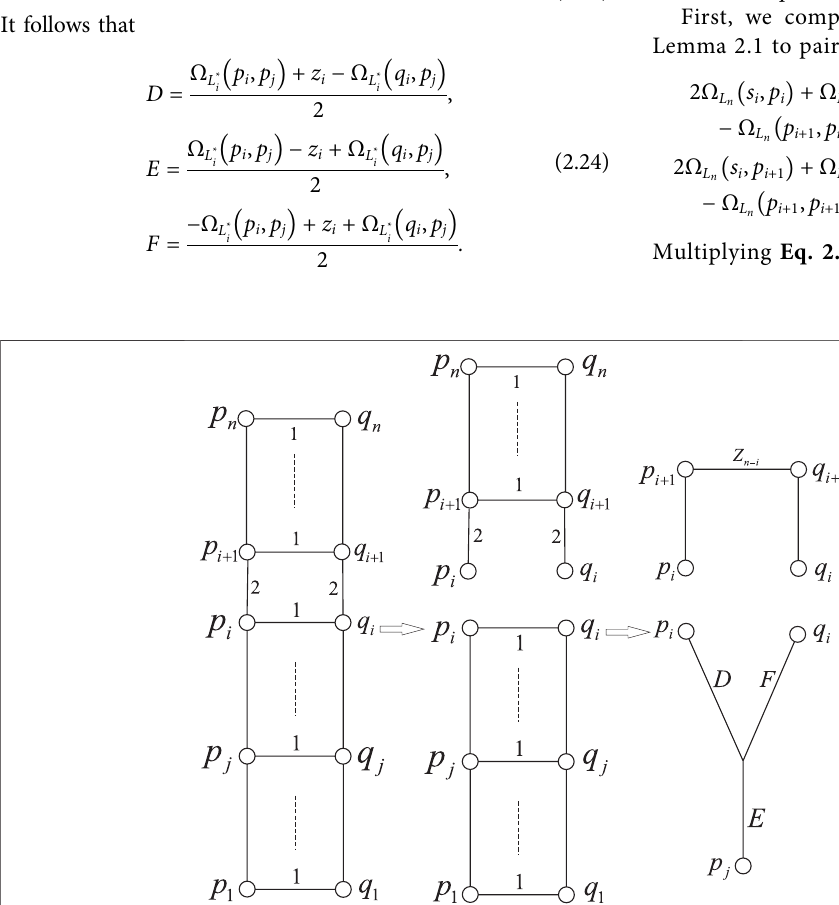
( p , p ) and Ω i j n